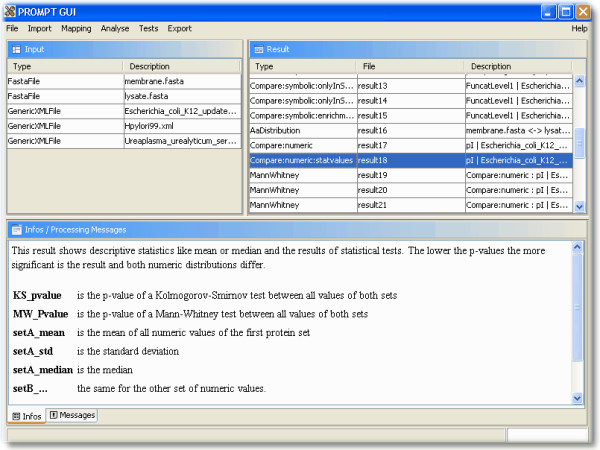
Graphical User Interface (GUI). Shown is a typical workspace session with input data and results. The information panel in the bottom part of the screen provides context sensitive information related to the current user action.